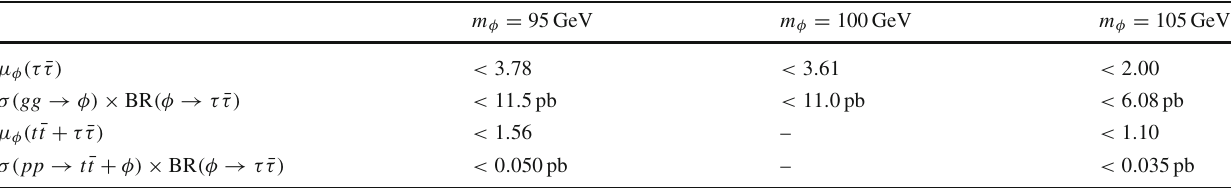
Table 1 The 95% CL upper limits on the signal strengths ( μ φ ) and the production cross sections for m φ = 95 , 100 , 105GeV are summa- rized. These limits are obtained from the ATLAS Run 2 full data [55]